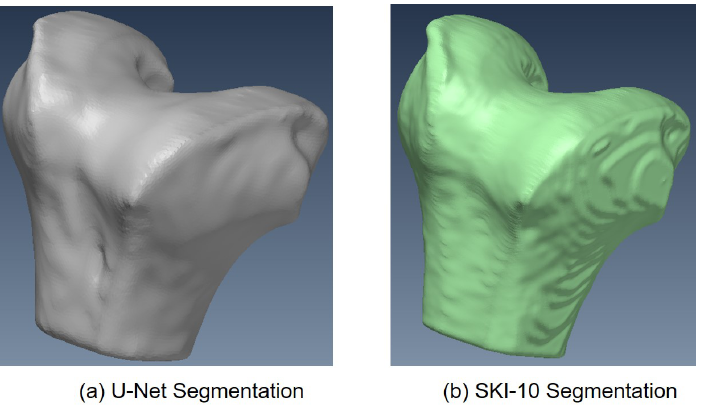
Figure 11. Femur 3D mesh model produced by ( a ) U-net and ( b ) the SKI10 ground truth.